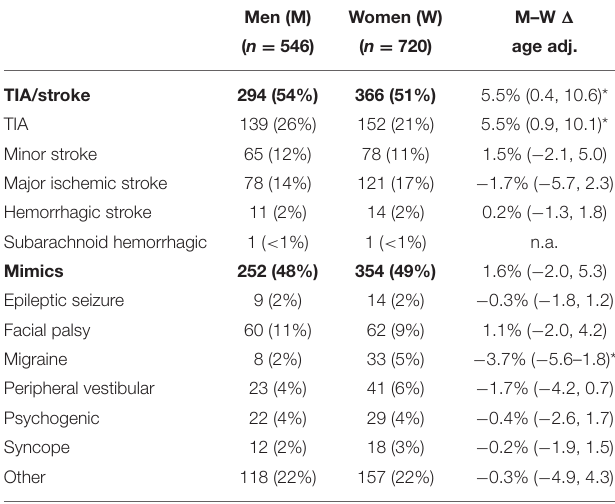
TABLE 2 | Diagnosis by gender of patients with suspected